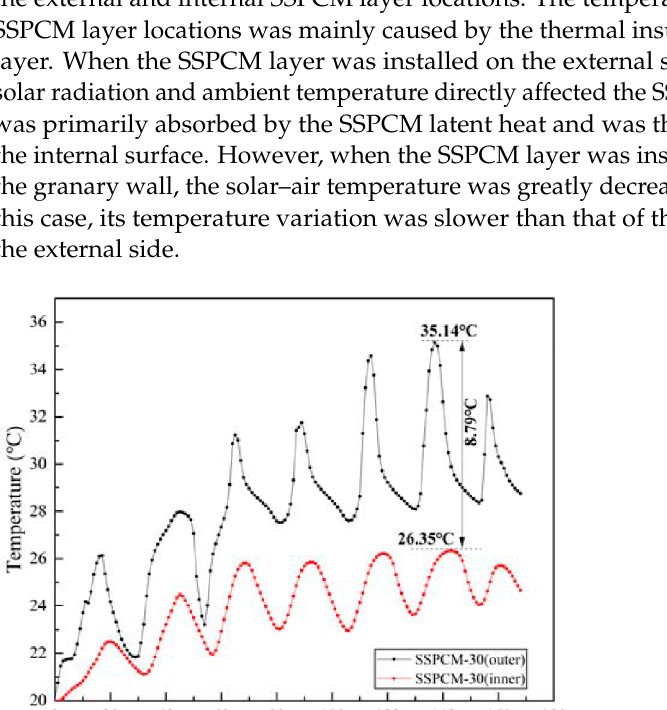
Figure 13. The internal surface temperature of SSPCM granary wall with different position.